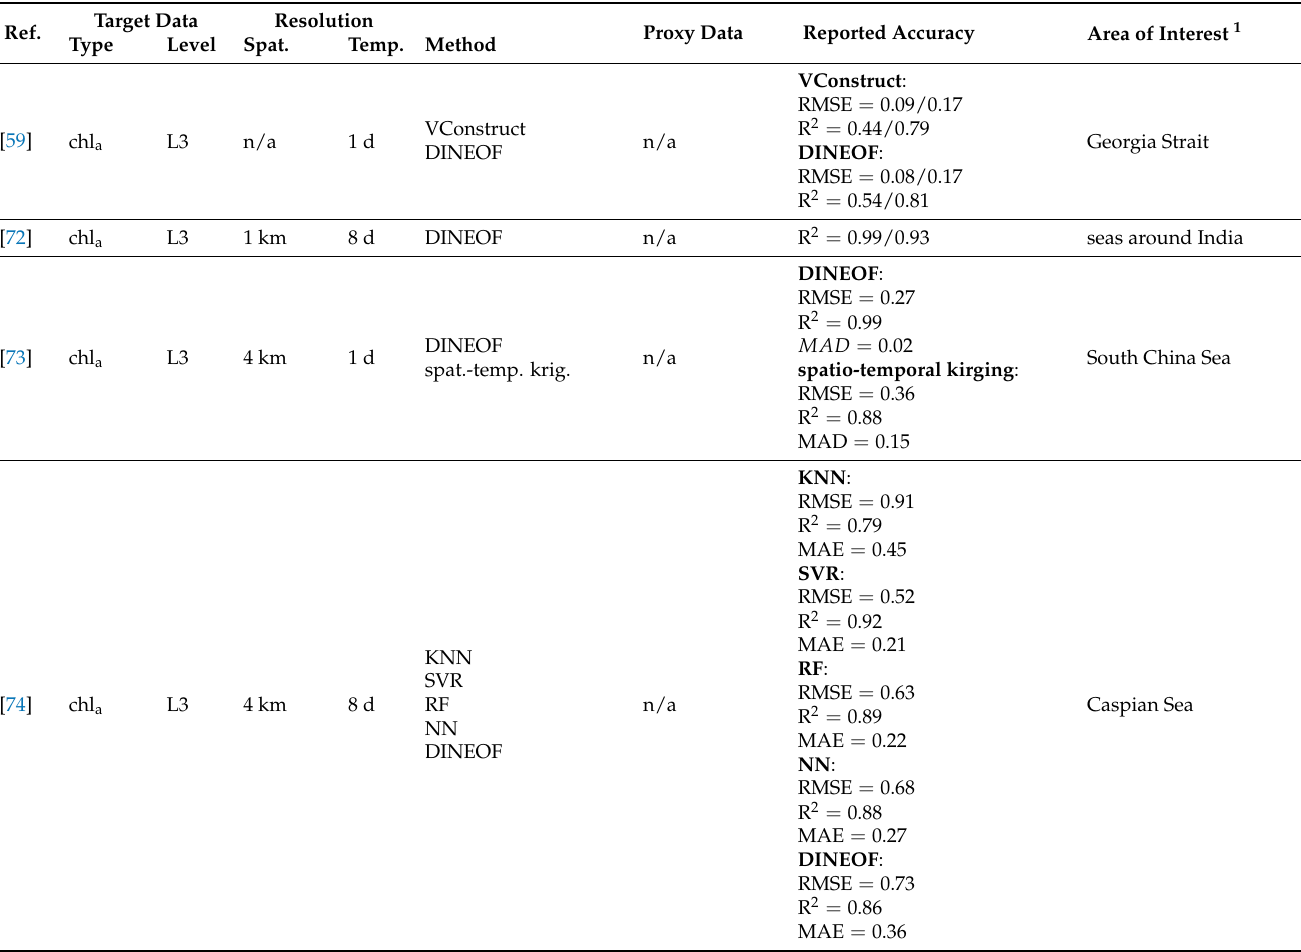
Table A1. Information obtained from the surveyed articles. 1 Names are taken from references where